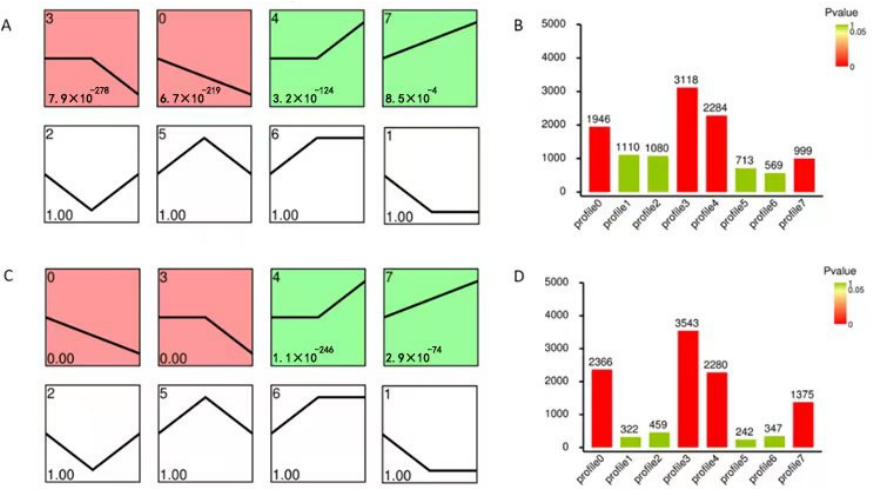
Figure 4. Expression profiles of DEGs involved in the eight clusters. Patterns of gene expression across three time points (CK, 2 h, and 12 h) under low-temperature stress treatment in WT ( A ) and M3 plants ( C ). Profile 0 and Profile 3 colored with red in ( A , C ) indicated up-regulated expression tendency, while Profile 4 and Profile 7 colored with green indicated down-regulated expression tendency ( p ≤ 0.05). The Profile 1, 2, 5, 6 in ( A , C ) filled with white color indicated p value greater than 0.05. In each profile, the black line represents the expression tendency. The top left-hand corner indicates the number of profiles, while the lower left-hand corner contains the p -values of the profile. The number of genes belonging to each cluster is shown in the WT ( B ) and in M3 plants ( D